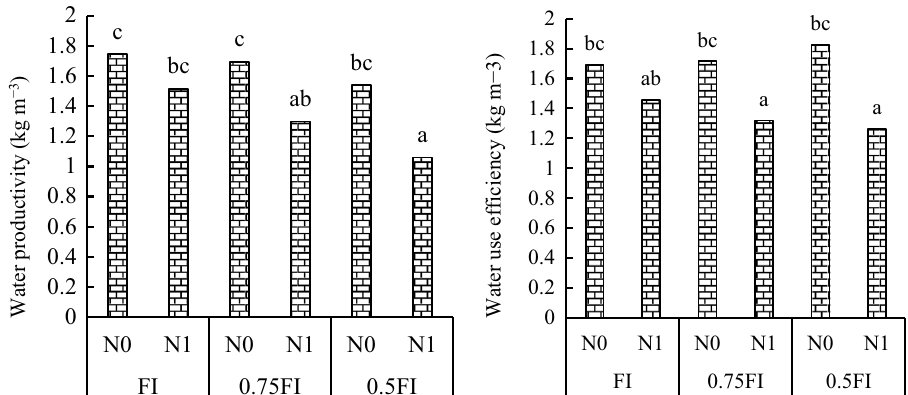
Figure 3. The effect of irrigation × nitrogen fertilizer interaction on water productivity ( A ) and water use efficiency ( B ) in pea. FI: full irrigation, N: nitrogen. The data averaged over sowing date and two years. Means with different letters did differ significantly